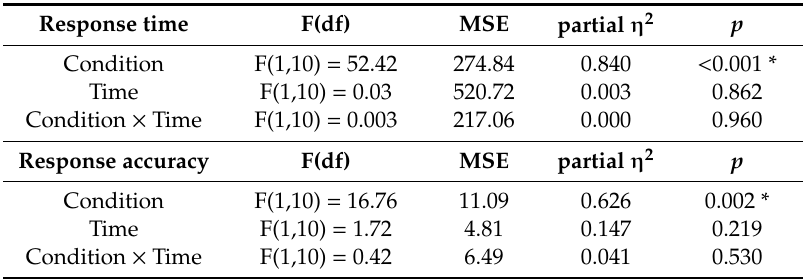
Table 2. Statistics on the analyses of response times and response accuracy.